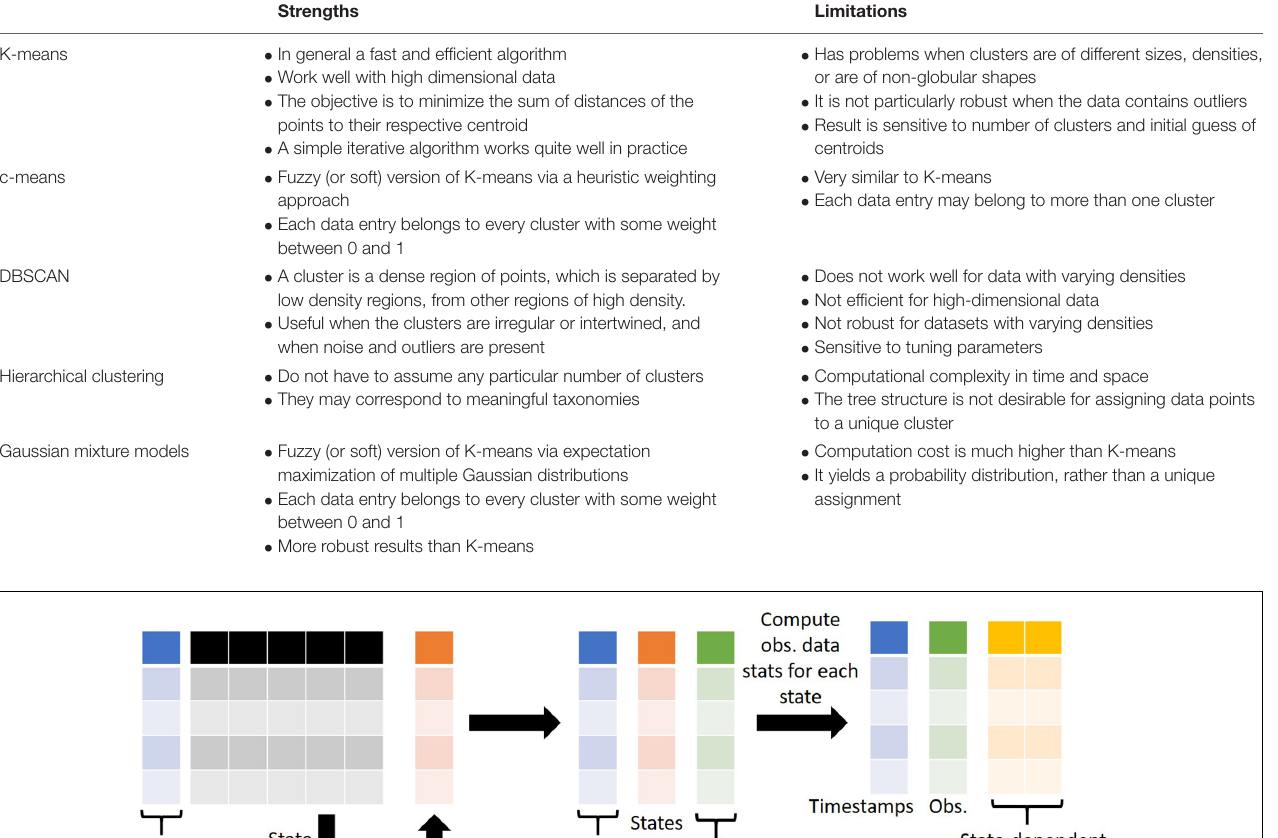
TABLE 2 | A comparison of various unsupervised clustering-based classification methods.